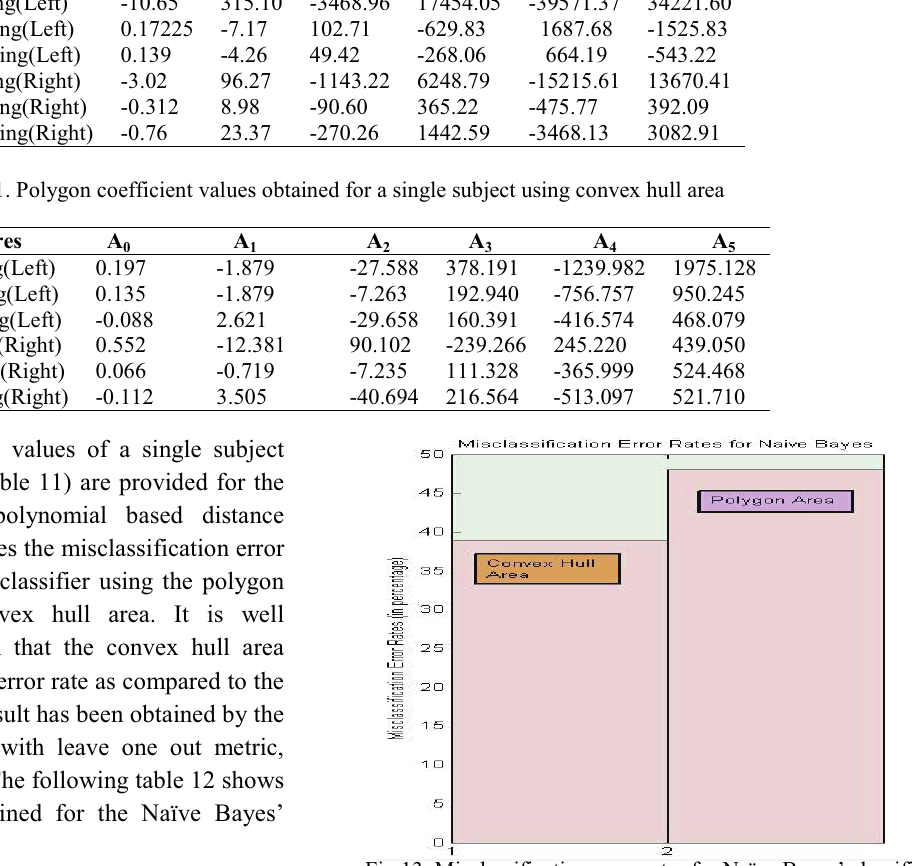
Table 12. Statistical measurement for Naïve Bayes’ rule